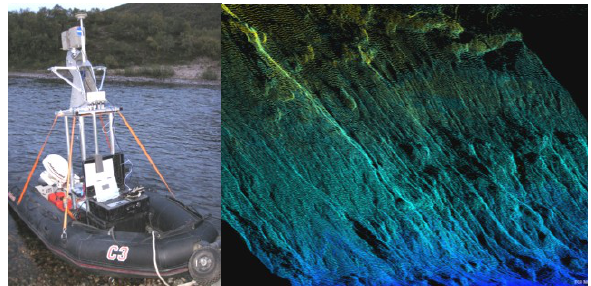
Figure 4. Left: Boat mounted MLS system for mapping of fluvial processes. Right: 20 meters high river bank subject to flood erosion mapped with boat MLS.